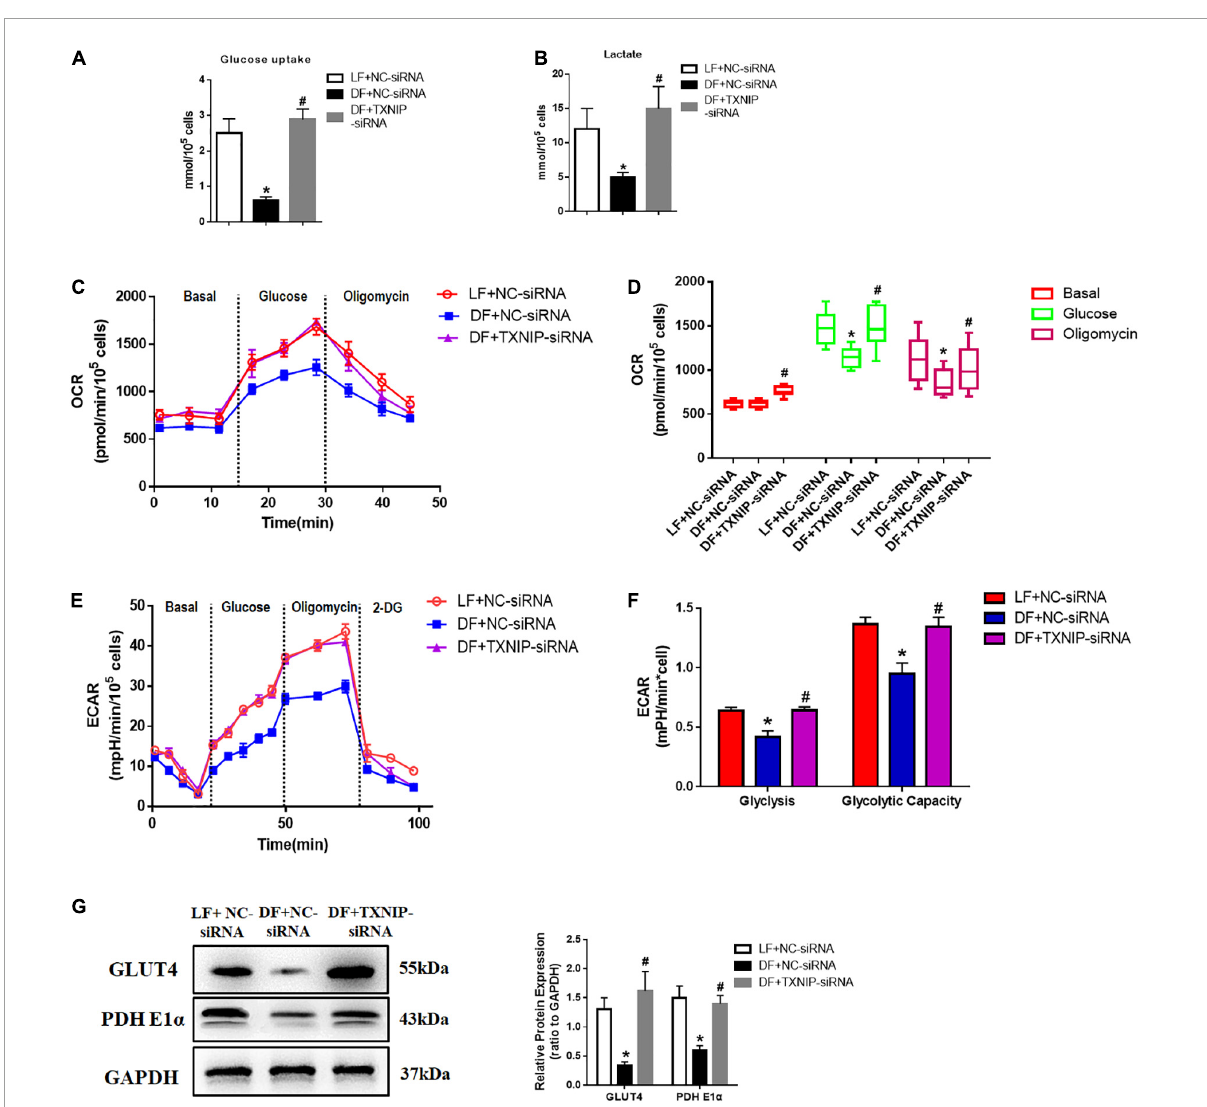
FIGURE5 Disturbed flow decreased glucose utilization through TXNIP-dependent activation. (A) Glucose uptake, (B) Lactate production, (C) Kinetic oxygen consumption rate (OCR) responses of HUVECs to 20 mM glucose and 5 mM oligomycin, (D) Calculated glucose oxidation rate, (E) Kinetic extracellular acidification rate (ECAR) responses of HUVECs to glucose (20 mM), oligomycin (5 µ M) and 2-DG (100 mM), in the LF + NC-siRNA, DF + NC-siRNA, and DF + TXNIP-siRNA treatment groups. (F) Calculated glycolytic flux and glycolytic capacity. The glycolytic flux and glycolytic capacity are calculated by ECAR increase normalized with cell protein content. (G) GLUT4 and PDH E1 α expression were determined by Western Blotting in the treatment groups of laminar flow with negative control siRNA (LF + NC-siRNA), disturbed flow with negative control siRNA (DF + NC-siRNA), and disturbed flow with TXNIP-siRNA (DF + TXNIP-siRNA). All values are presented as mean ± SD. N = 5/group. * P < 0.05 vs. LF + NC-siRNA, # P < 0.05 vs. DF +